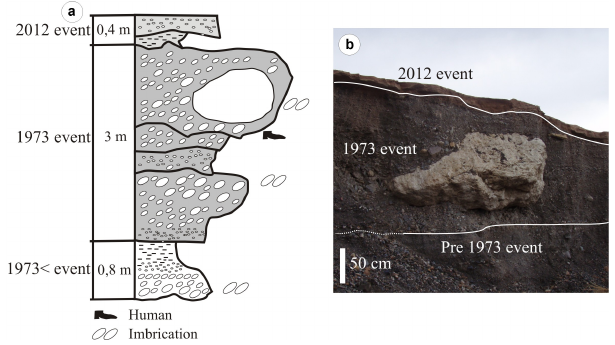
Figure 7. Sedimentary section from 2012, 1973 and older floods recorded in the banks of Nogalte Rambla at Puerto Lumbreras.